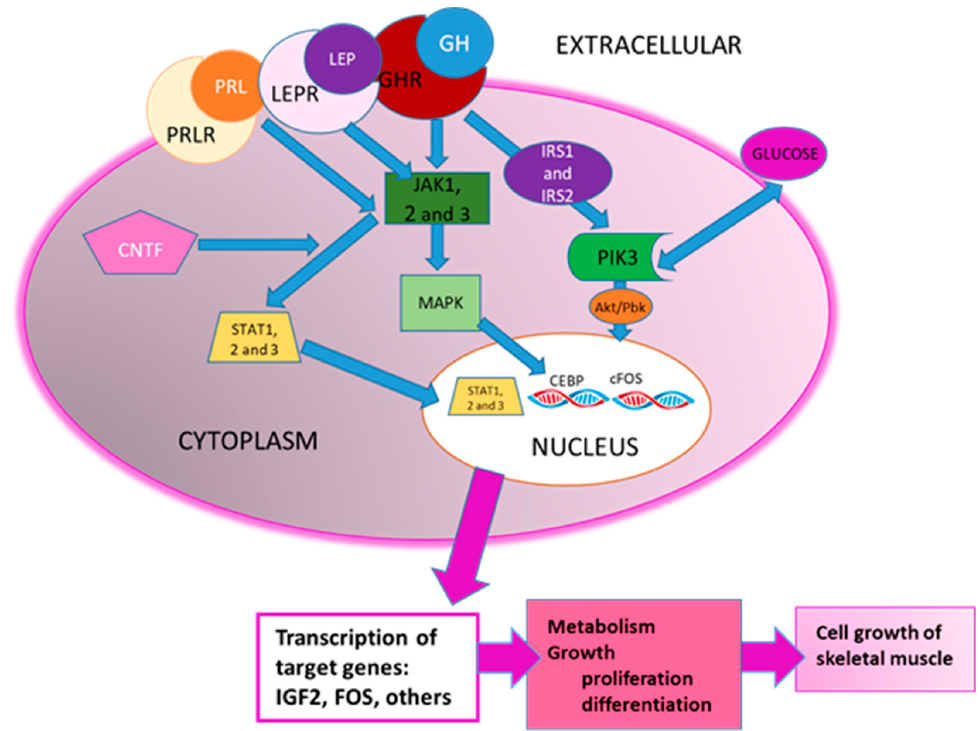
Figure 3. Integrative overview of signaling pathways related to muscle growth and development activated in muscle of grower pigs.